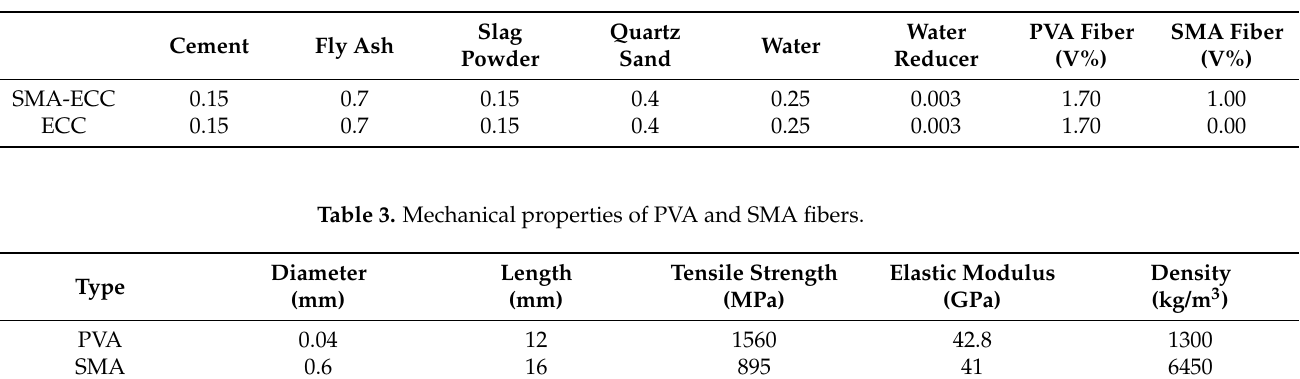
Table 2. Mix proportions of SMA-ECC and ECC (weight proportion).